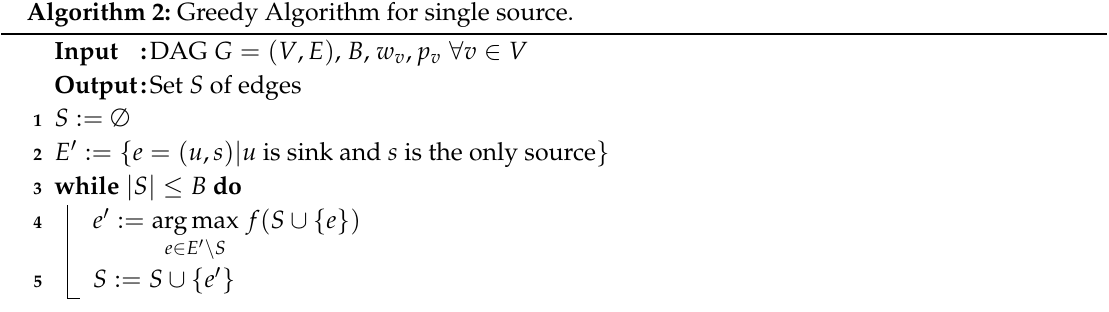
Algorithm 2: Greedy Algorithm for single